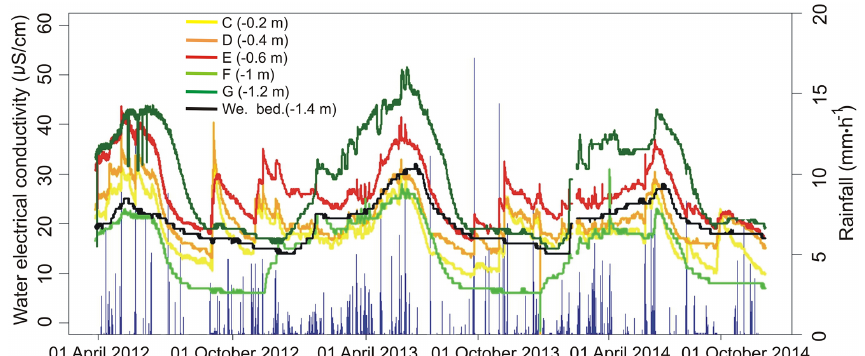
Figure 8. Monitored soil and weathered bedrock water electrical conductivity dynamics at the monitored test-site slope in the study